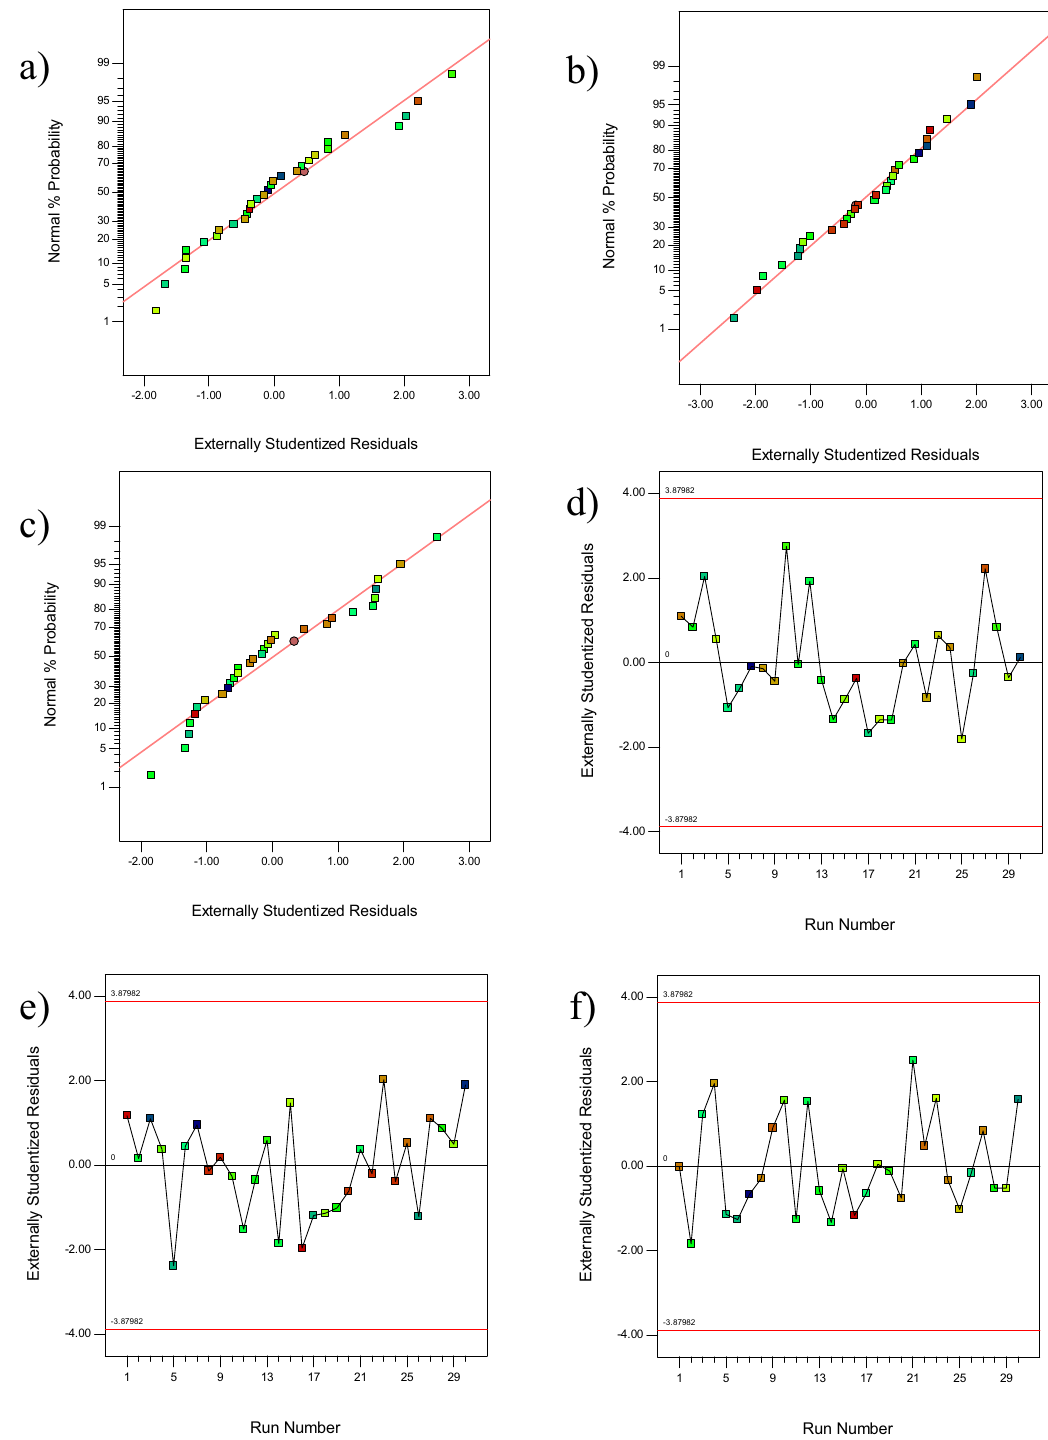
Figure 2. The normal plot of residuals for removal of ( a ) AO, ( b ) MB, ( c ) Cd (II), Plot of residuals versus run number for removal of ( d ) AO, ( e ) MB ( f ) Cd